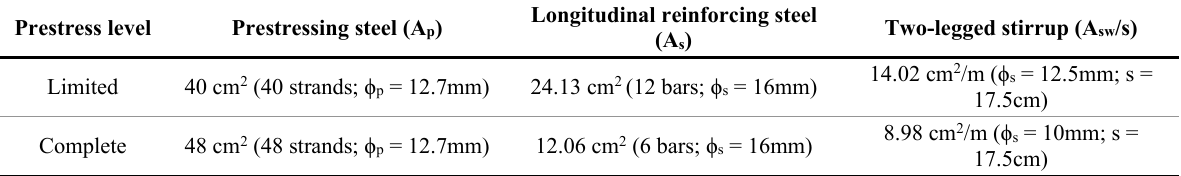
Table 5. Reinforcement areas according to prestress